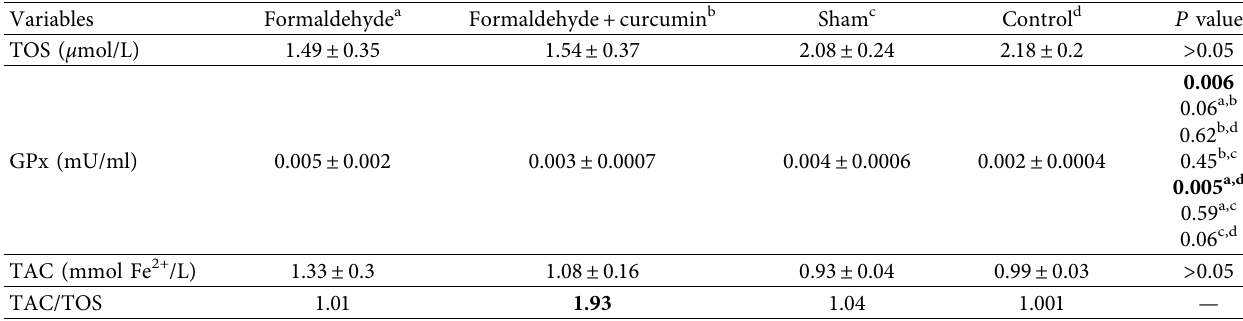
Table 4: Comparison of oxidant and antioxidant status among study groups.